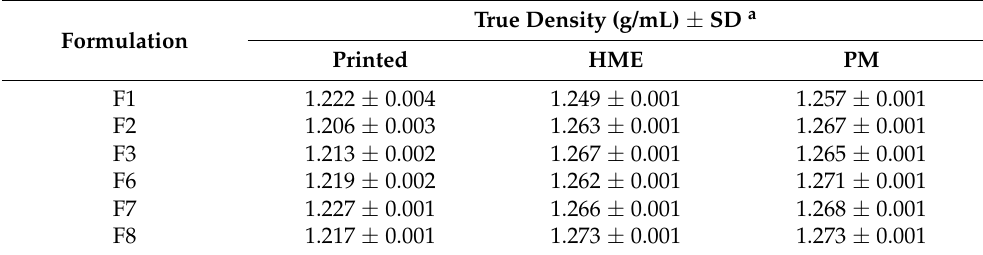
Table 6. The true density of tablets made via different techniques (n = 10).